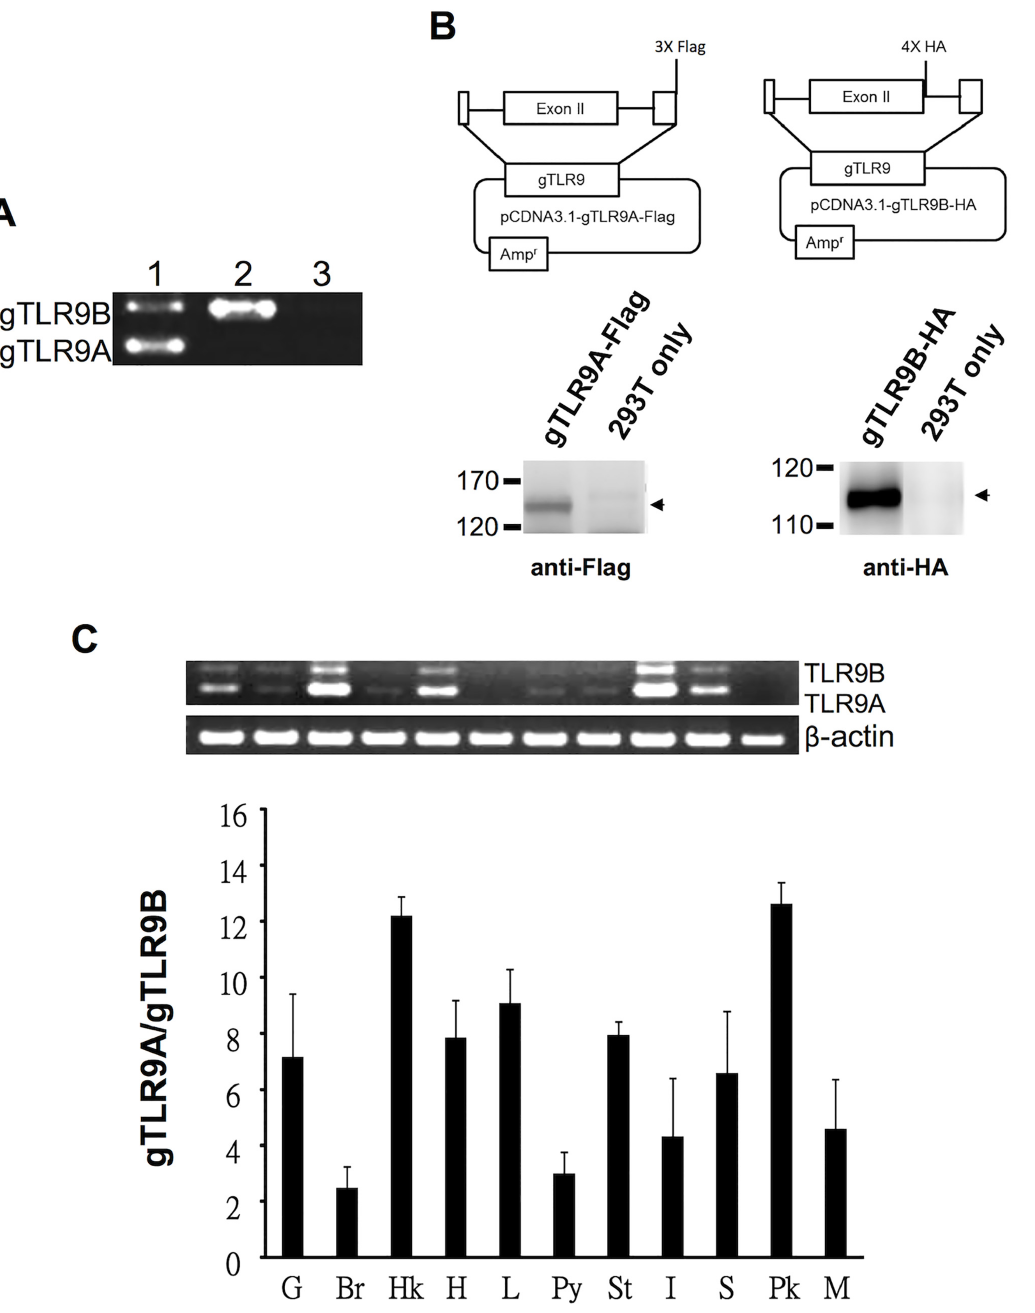
Fig 2. Transcriptional and translational capacity of the grouper Tlr9 gene. A , Transcriptional activity of the gTlr9 gene was assayed in HEK293T cells transfected with the plasmid pgTLR9-genomic, which contains the grouper Tlr9 gene sequence. The expression of gTlr9A and gTlr9B mRNAs in transfected cells was detected by RT-PCR with primers flanking intron 2 of gTlr9 . Lane 1, gTLR9-transfected HEK293T; lane 2, plasmid gTLR9; lane 3, non-transfected HEK293T. B , Translational activity of the grouper Tlr9 gene was assayed in HEK293T cells transfected with a plasmid containing the Tlr9 genomic sequence tagged with either Flag after exon 3 (gTLR9A-Flag) or HA in intron 2 (gTLR9B-HA). The expression of gTLR9A and gTLR9B proteins was confirmed by western blotting in cells transfected with gTLR9A-Flag and gTLR9B-HA, respectively. C , The tissue distribution and relative abundance of gTlr9A and gTlr9B transcripts were assayed by RT-PCR (upper panel) and RT-qPCR (lower panel) with three fish. The upper panel documents the data of one representative fish. In the lower panel, the RT-qPCR results are presented as the mean ± SD of the data from the three fish. Both mRNAs were predominately detected in immune-related tissues. St, stomach; Py, pyloric ceca; Sp, spleen; Pk, posterior (head) kidney; Br, brain; In, intestine; Hk, heard kidney; G, gills; L, liver; Hr, heart; M, muscle.